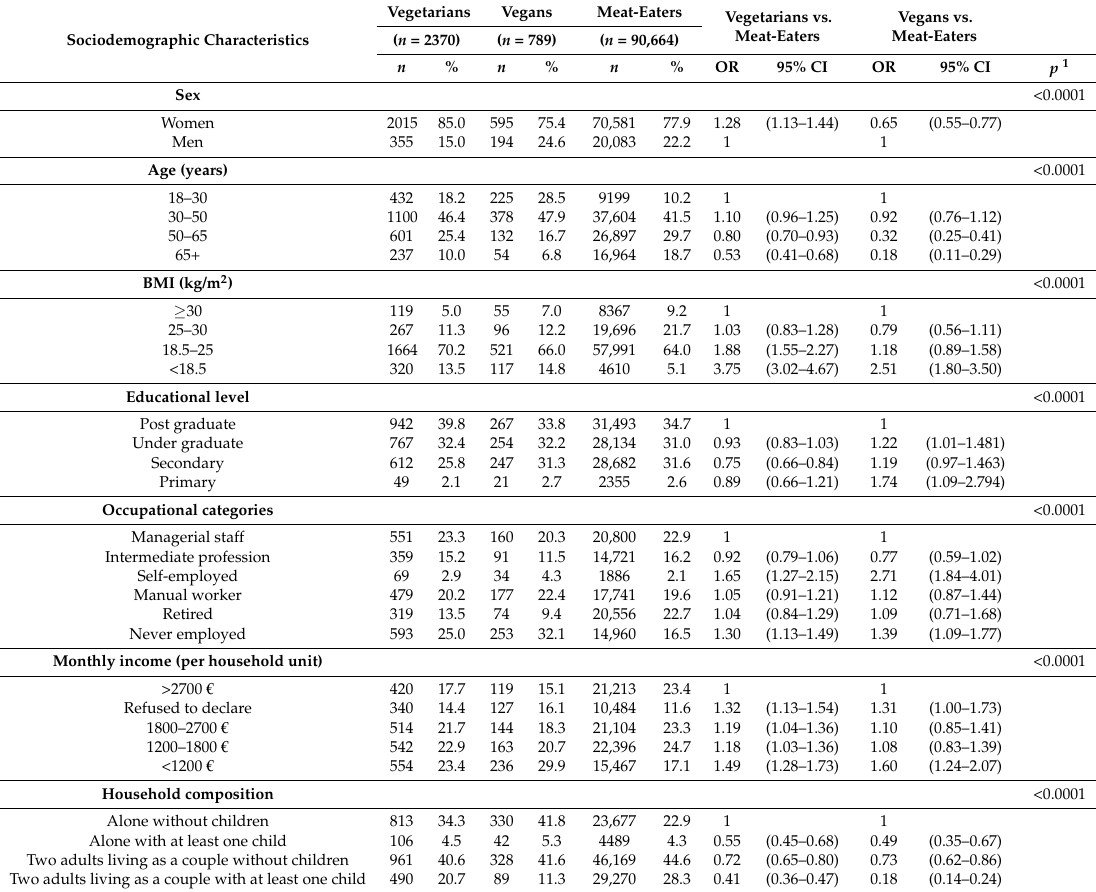
Table 2. Associations between sociodemographic characteristics and vegetarian and vegan diets using polytomic logistic regression models (reference diet: meat-eaters, Nutrinet-Sant é Study 2009–2015, n = 93,823).